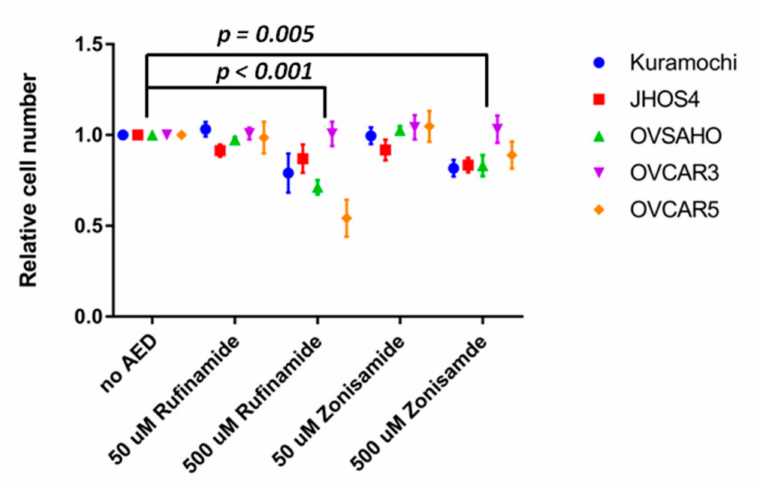
Figure 3. Effect of treatment with anti-epileptic drugs (AEDs) on epithelial ovarian cancer cell proliferation. Two-way ANOVA adjusted for multiple